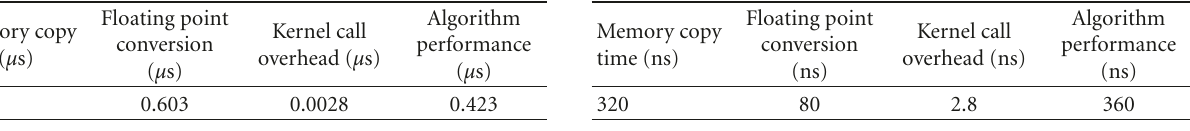
Table 2: Break down of calculation time. Table 3: Break down of calculation